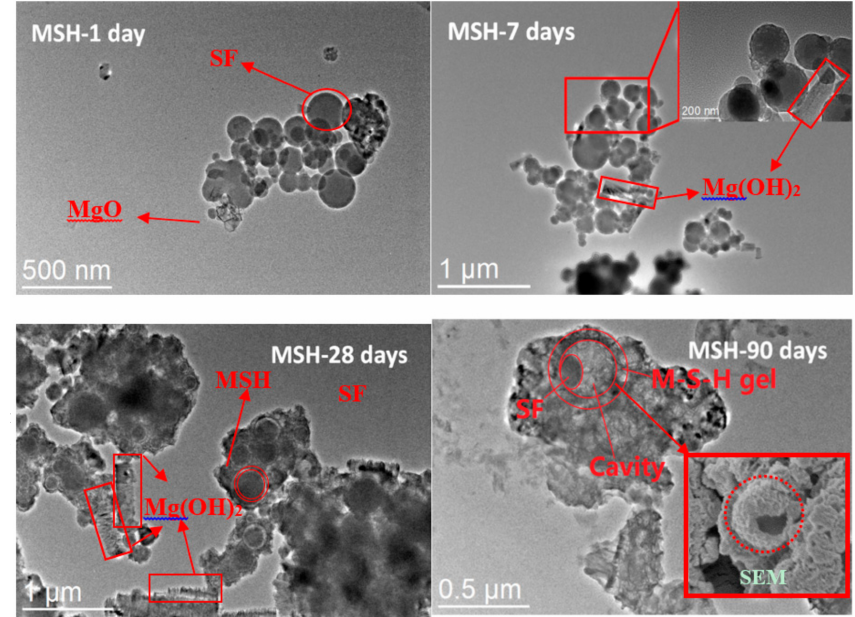
Figure 9. Transmission electron microscopy (TEM) bright field images of samples with different curing times. After 1 day, the spherical particles of the silica fume (SF) can still be found. As curing time extends, the particles gets covered and slowly consumed by MSH gel, forming the shell structure with